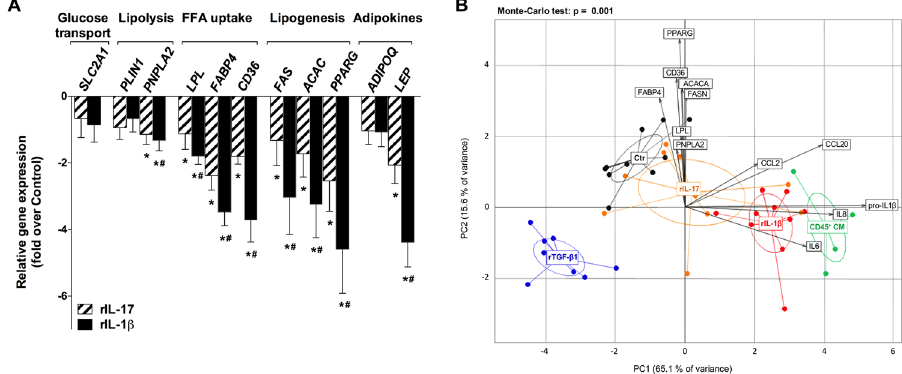
Figure 4. Down-regulation of metabolic genes in primary human adipocytes. ( A ) Metabolic gene mRNA levels were analyzed by QuantiGene Plex in primary human adipocytes cultured in Puramatrix hydrogel for 72 h (n = 10) and treated or not by rIL-17 (10 ng/mL) or rIL-1 β (10 ng/mL). * P < 0.05 versus untreated cells. # P < 0.05 versus rIL-17 treated cells. ( B ) Principal components analysis (PCA) plots of metabolic